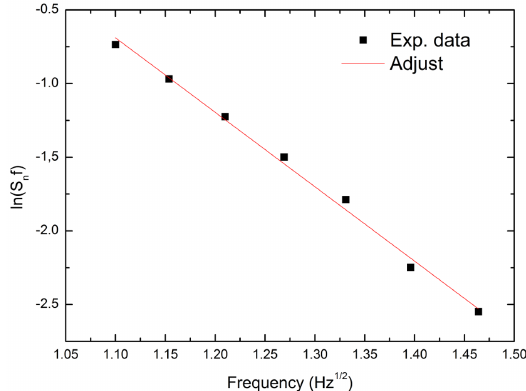
Figure 5. Phase variation of the photoacoustic signal with frequency f for the banana